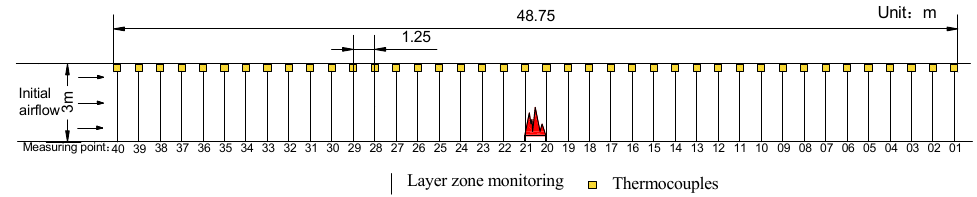
Figure 2. Layout of measuring.